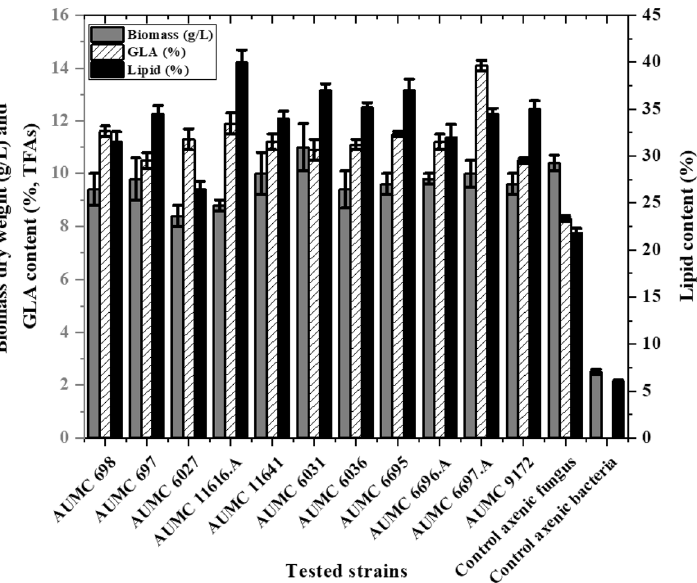
Figure 1. Fungal biomass, lipids, and GLA yields of assessed fungal strains cocultured with B. subtilis ATCC 6633 in K&R fermentation media for 4 days. Error bars represent the standard deviation (SD) of three biological replicates.